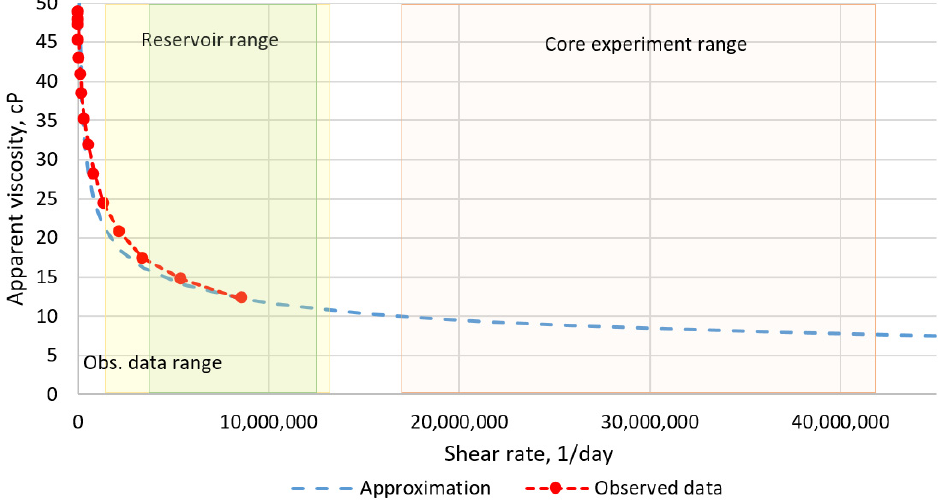
Figure 4. Influence of surfactant presence and its concentration on polymer solution viscosity.